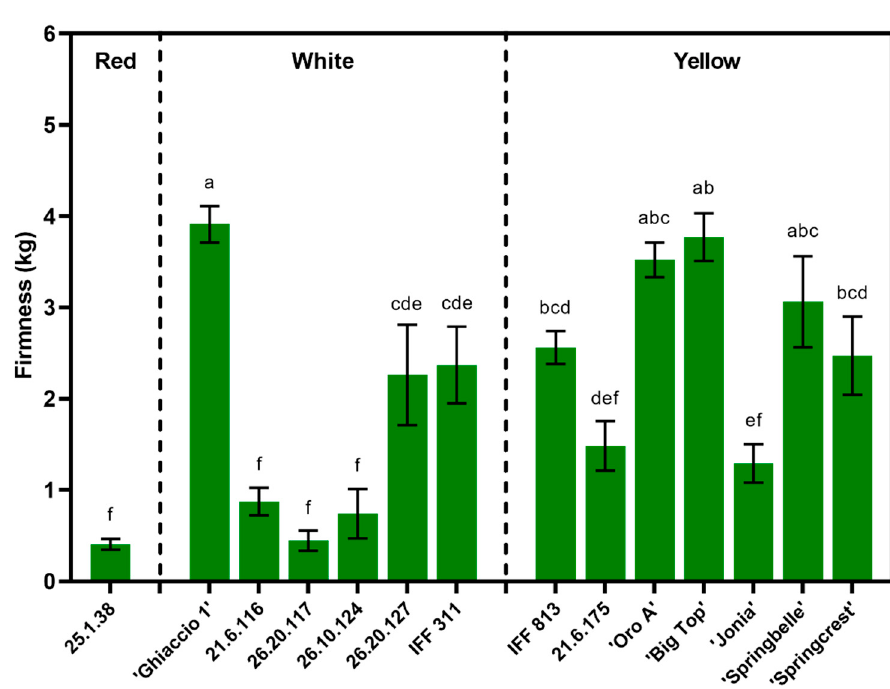
Figure 1. Firmness at harvest in 2007 for all commercial cultivars and breeding accessions divided by flesh color. Student Newman–Keuls (SNK) test used for post-hoc mean comparisons. Columns with the same letter above indicate non-significance at p < 0.05. Means ± S.E. displayed.